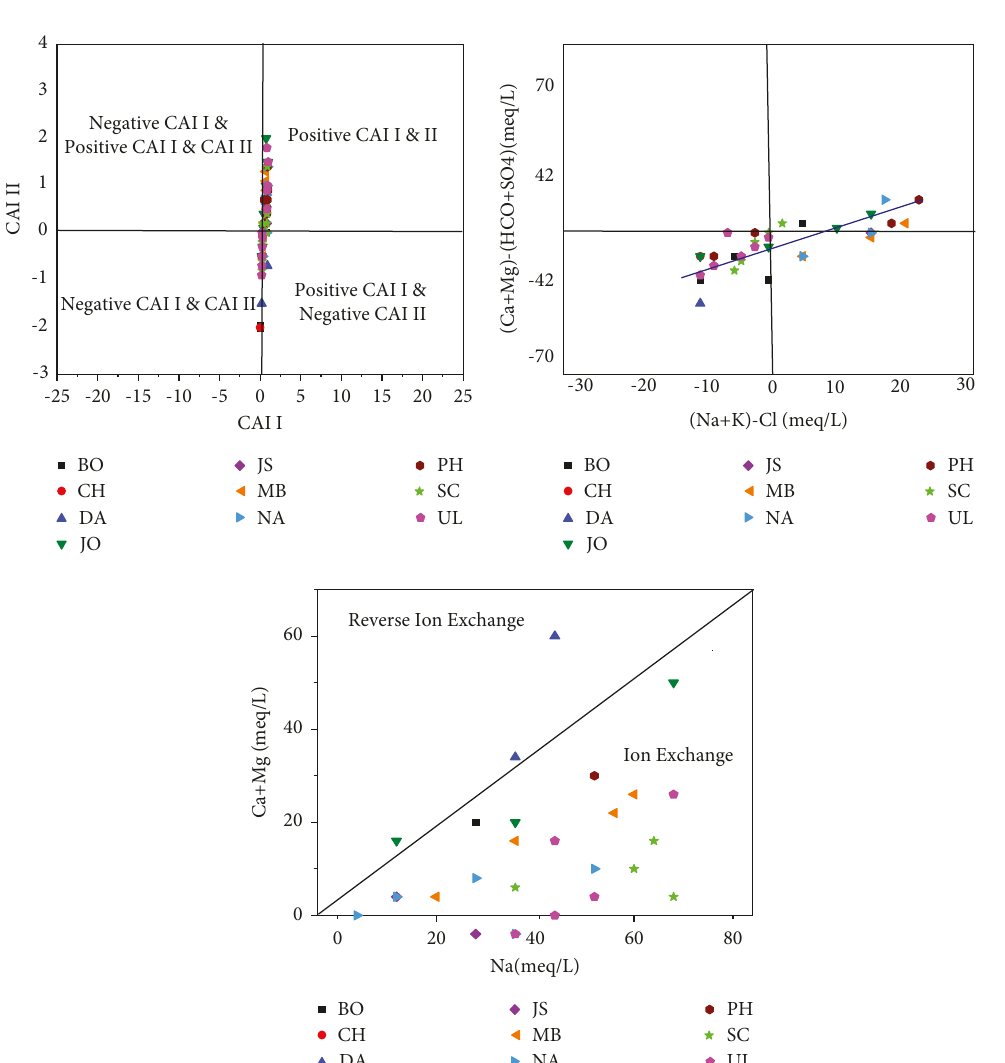
Figure 5: Gibbs plot (a) cations (b) anions.